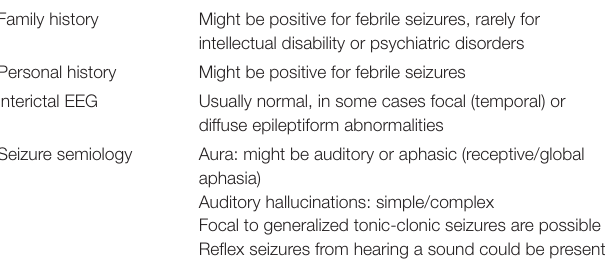
TABLE 2 | Clinical features of EAF [adapted from (21)]. Family